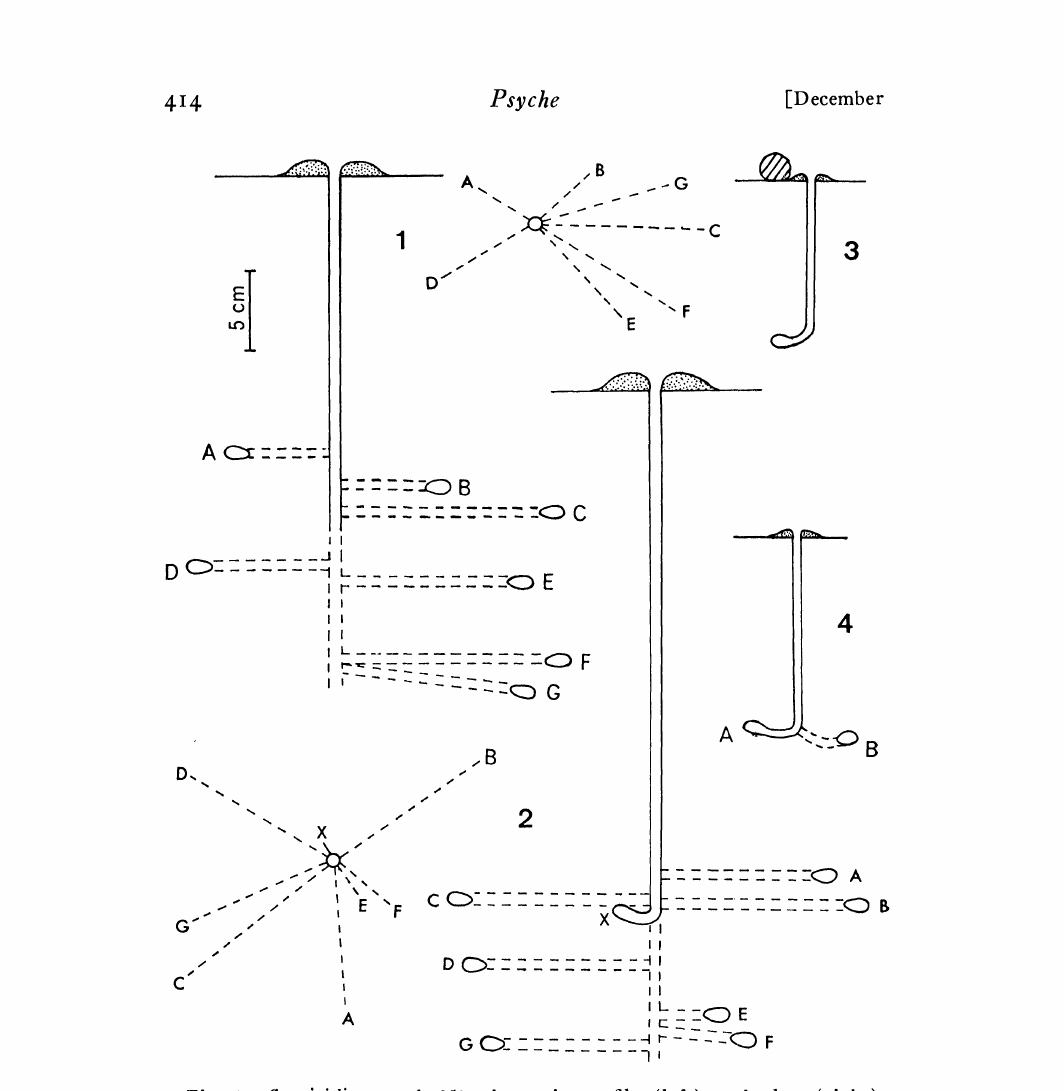
Fig. 1. 8. iridis, no. A 258, shown in profile (left) and plan (right). Cells ]3 and E contained eggs, cell F a cocoon. Contents of the other cells were molded. Fig. 2. S. iridis, no. AM 144, shown in plan (left) and profile (right). Eggs or fresh flies were present in cells A, B, C and D. The contents of cell E were molded; cell F contained a half-grown larva and cell G a cocoon. The blind end of the burrow is indicated by an X. Fig. 3. S. relucens, no. AM 133, in profile. Fig. 4. S. relucens, no. AM 152, in profile; both cells contained fresh